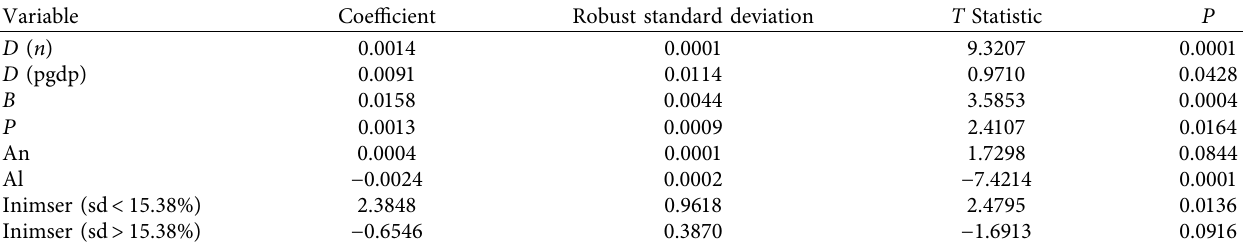
Table 3: Estimation results for urban governments’ cumulative debt ratio threshold.